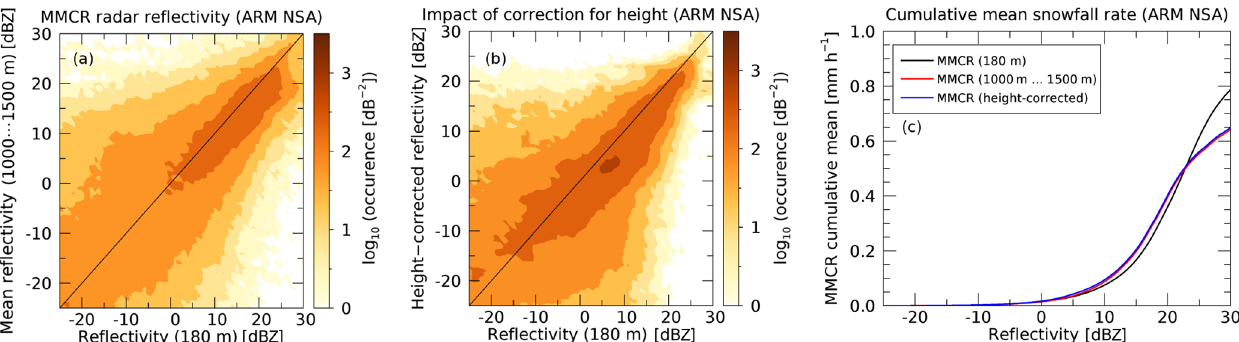
Figure 8. Same as Fig. 7 but for the DOE ARM site at the North Slope of Alaska (NSA) at Barrow, Alaska. The figures are based on 1.08 million radar profiles obtained between November 2008 and April 2011. Only data for the winter months of November through April are shown. The Barrow MMCR data were obtained from https://www.archive.arm.gov/discovery/ (last access: 9 June 2019).